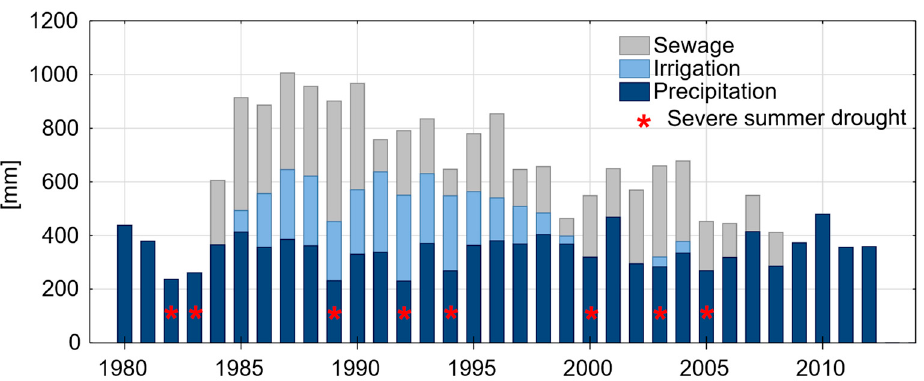
Figure 11. The amounts of water supplied to the stands at the Forest Wastewater Treatment Plant during the growing season in the period 1984–2010. Data on sewage and irrigation were obtained from the Iława Forest District. The years in which droughts occurred in the Iława Forest District are marked.